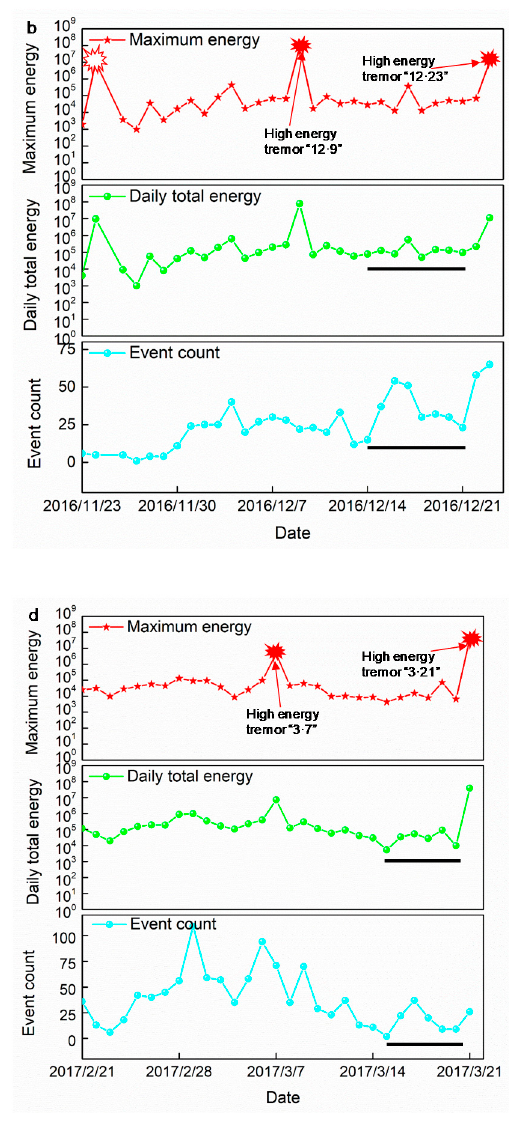
Figure 9. Event count deviation temporal evolution law before and after the rockbursts and high energy tremors. Therefore, in the monitoring and early warning of rockburst and high energy tremor, not only the original parameters such as MS energy should be considered, but also the trend of changes in the original parameters should be considered comprehensively. The appearance of a peak value of energy deviation ( ≥ 20) and event count deviation ( ≥ 1) can be regarded as an effective precursory sign that indicates imminent rockburst danger. The